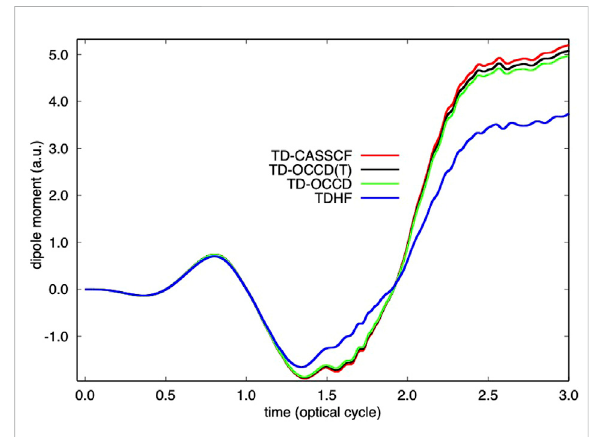
FIGURE 1 Time evolution of dipole moment of Kr irradiated by a laser pulse with a wavelength of 800 nm and a peak intensity of 2 × 10 14 W/cm 2 calculated with TDHF, TD-OCCD, TD-OCCD(T), and TD-CASSCF